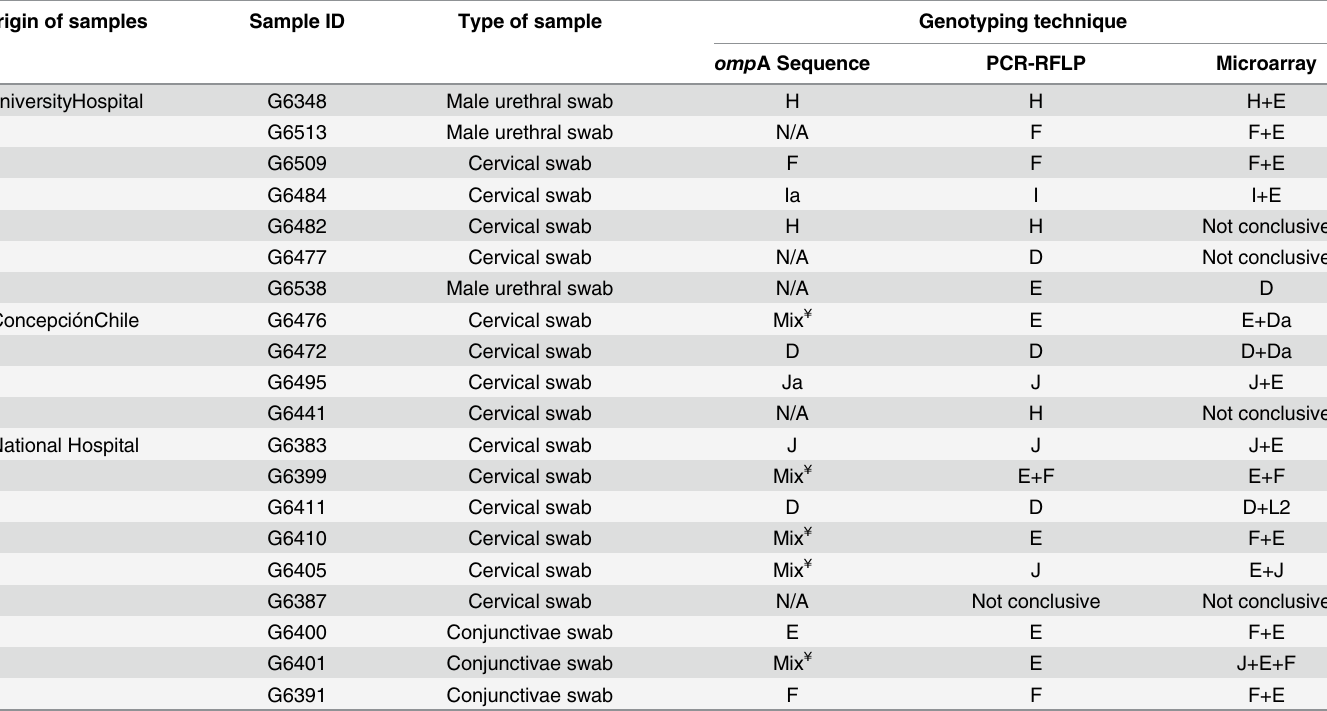
N/A: not available due to low DNA content or no sample left to perform analysis. ¥ not analyzable due to mixed genotype